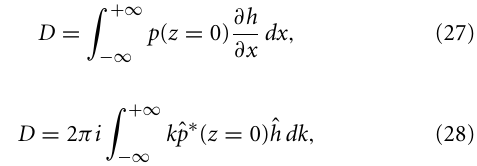
top (dashed blue line) and rotors (curved green arrows, see section 8). Note that throughout most of this paper, except in section 11, the boundary layer is neglected and a free-slip boundary condition is assumed at the